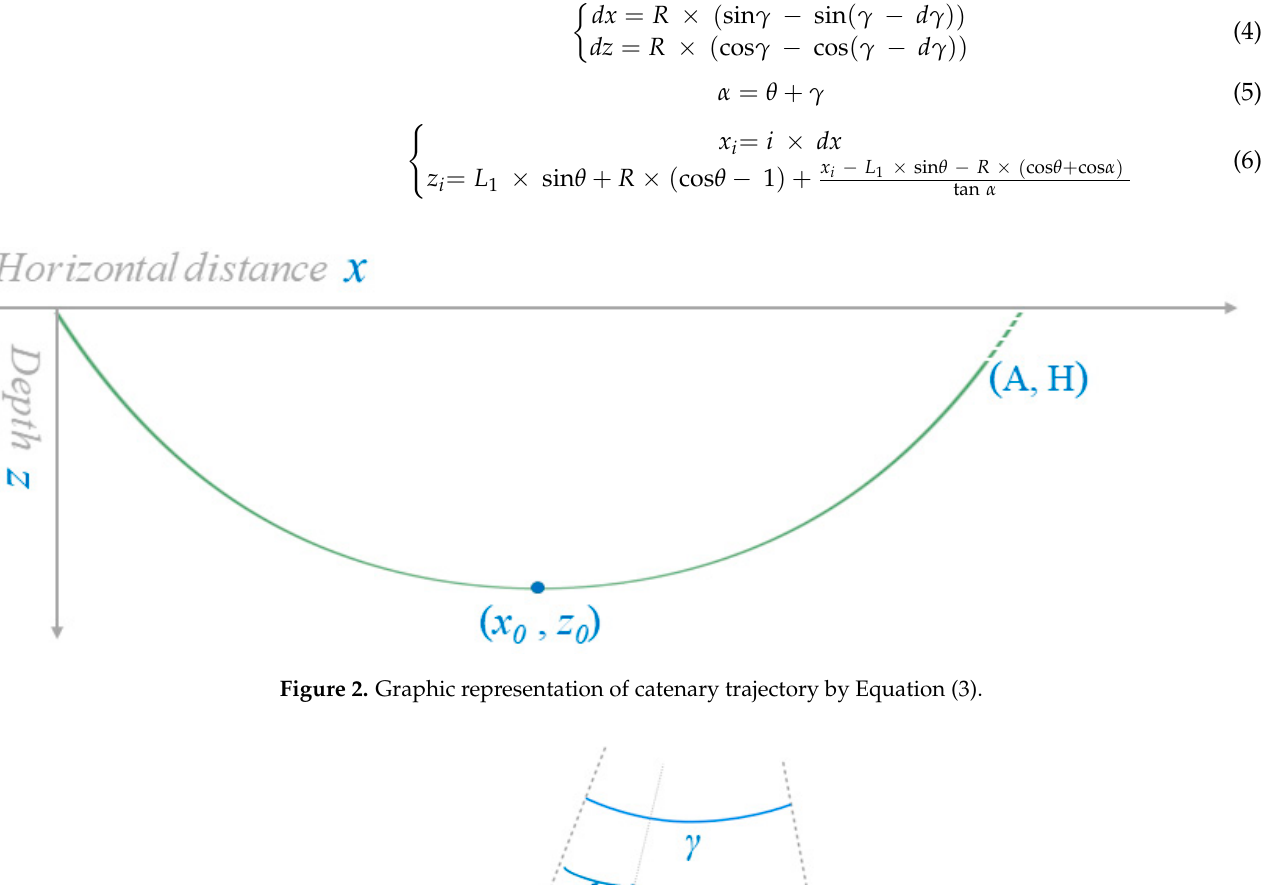
Figure 2. Graphic representation of catenary trajectory by Equation (3).